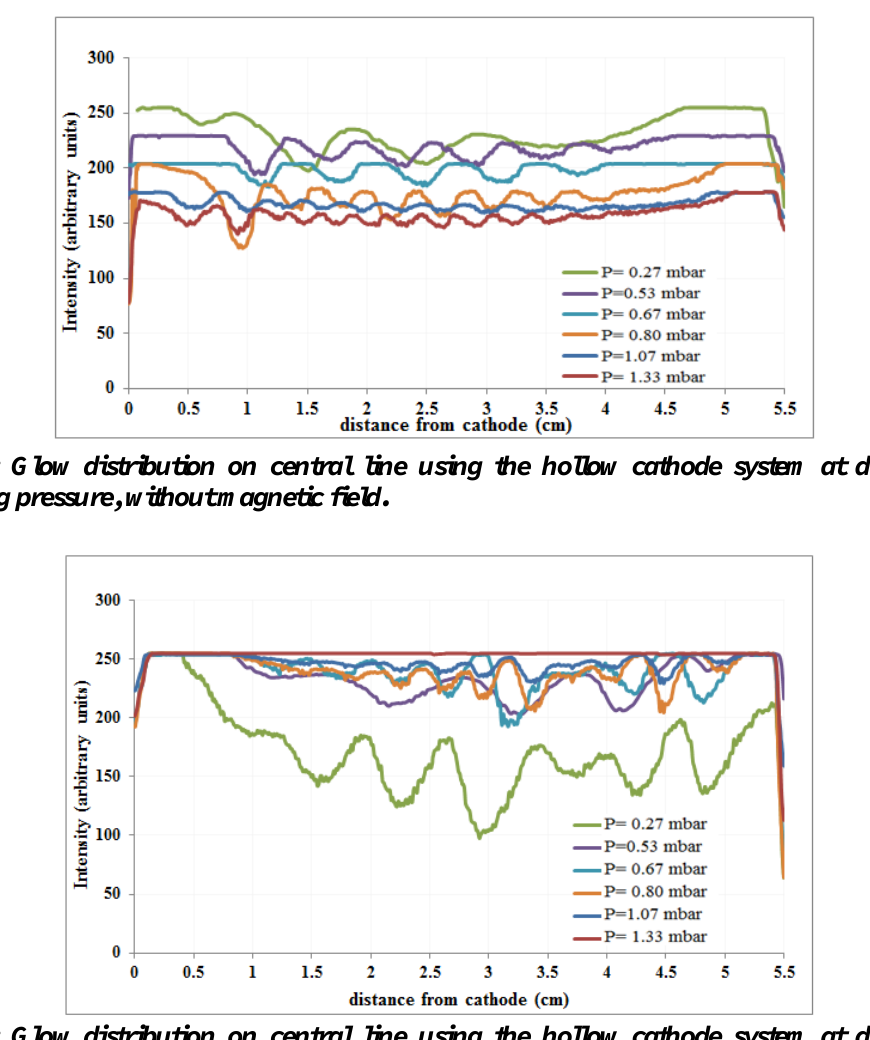
Fig. 7: Glow distribution on central line using the hollow cathode system at different working pressure, with magnetic